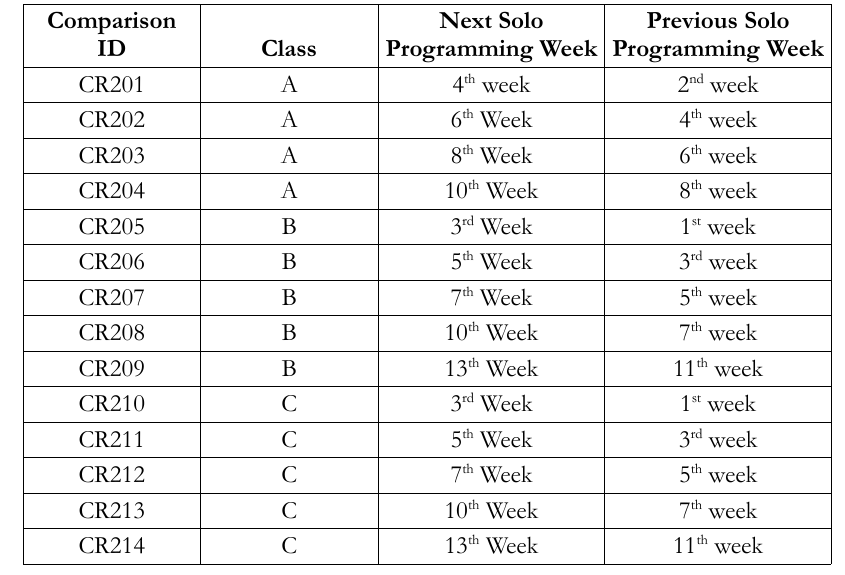
Table 6. Comparisons for Evaluating the Individual Impact of Pair Programming on the Academic Performance of Slow-Paced Students